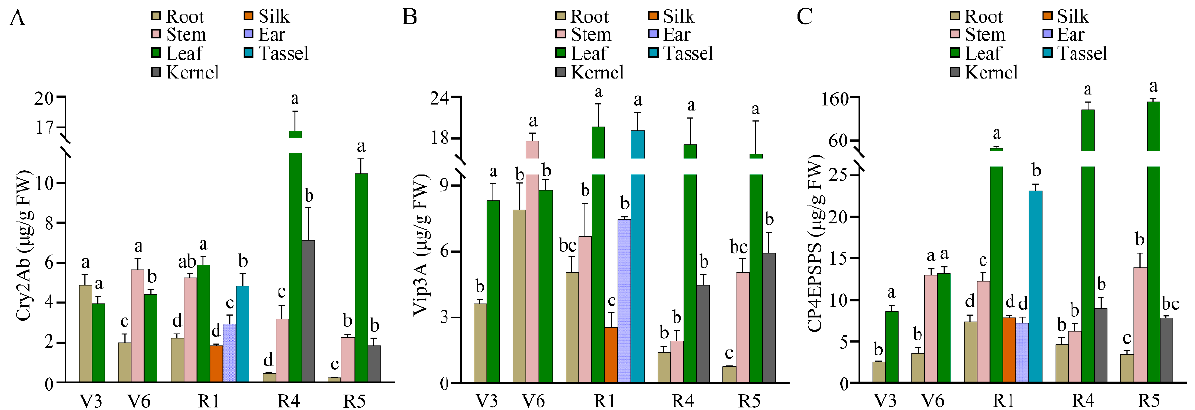
Figure 6. Protein expression levels of Cry2Ab ( A ), Vip3A ( B ), and CP4EPSPS ( C ) in the transgenic maize CVC-1. The data in all samples are presented as means ± standard deviation ( n = 3). Different lowercase letters indicate significant differences among the plant tissues at the same developmental stages with Duncan’s multiple range test (one-way ANOVA; p < 0.05). FW, fresh weight of tissue.